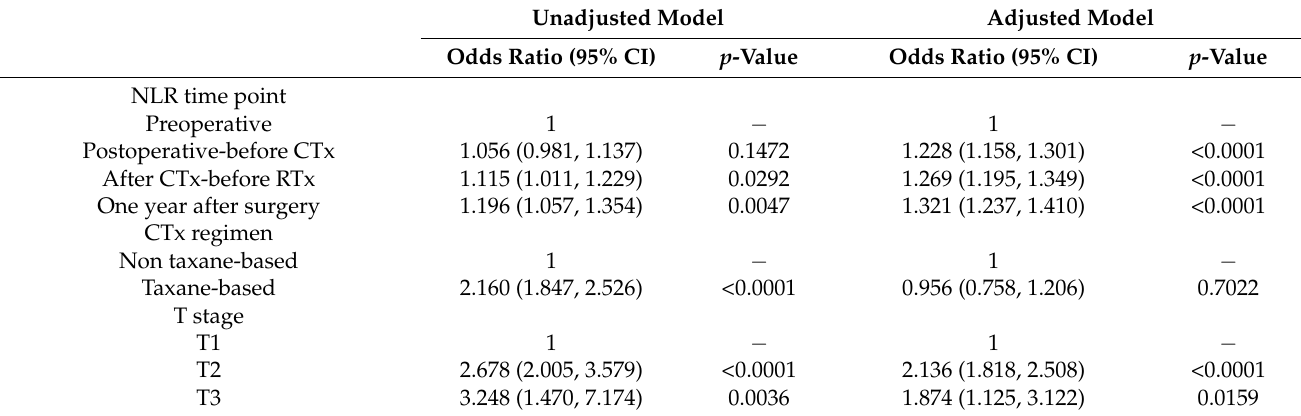
Table 3. Linear mixed model analysis